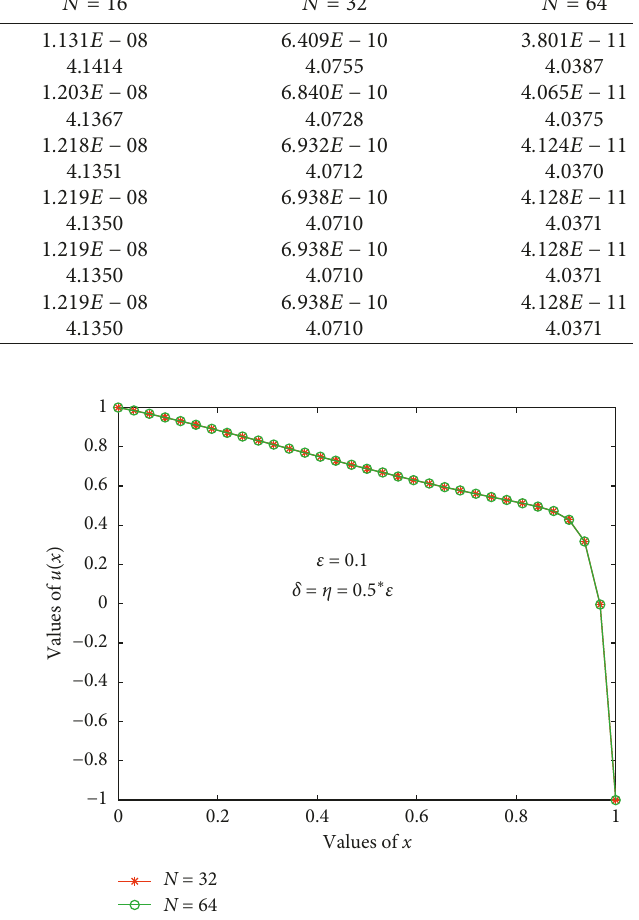
Figure 6: Approximate solution of Example 4 for different values of N